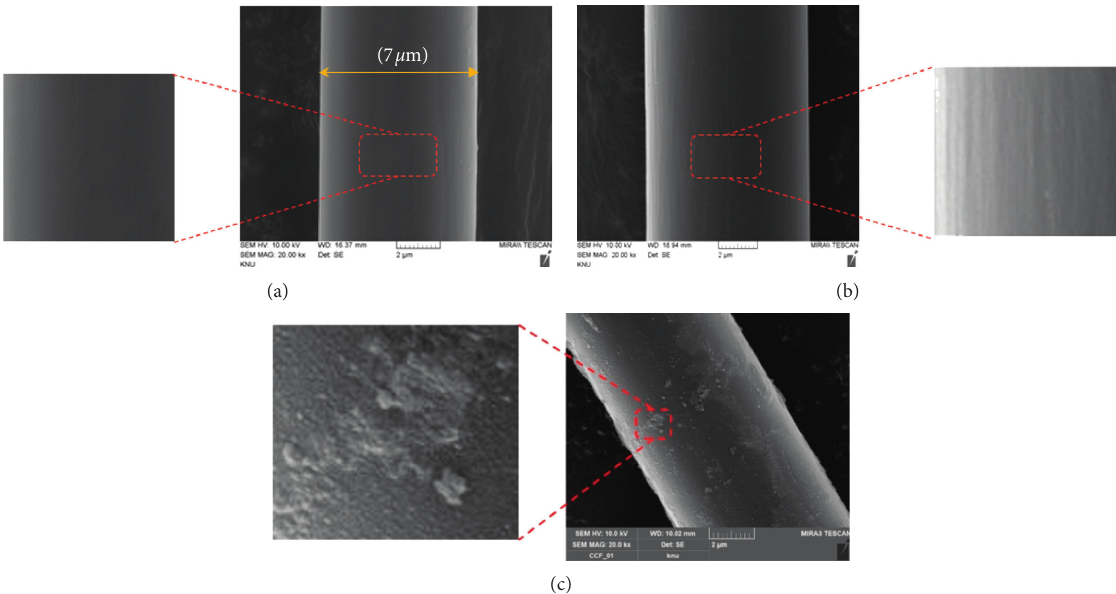
Figure 4: Surface topography of carbon fibers (20000 times): (a) uncoated carbon fiber, (b) nitric acid-treated carbon fiber, and (c) SiO coated carbon